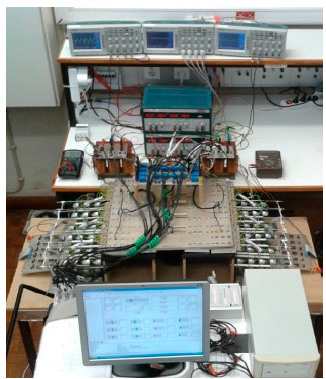
Figure 4. Experimental set-up including the five level NPC back-to-back converter and the DSP-based controllers. Table 1. System parameters.